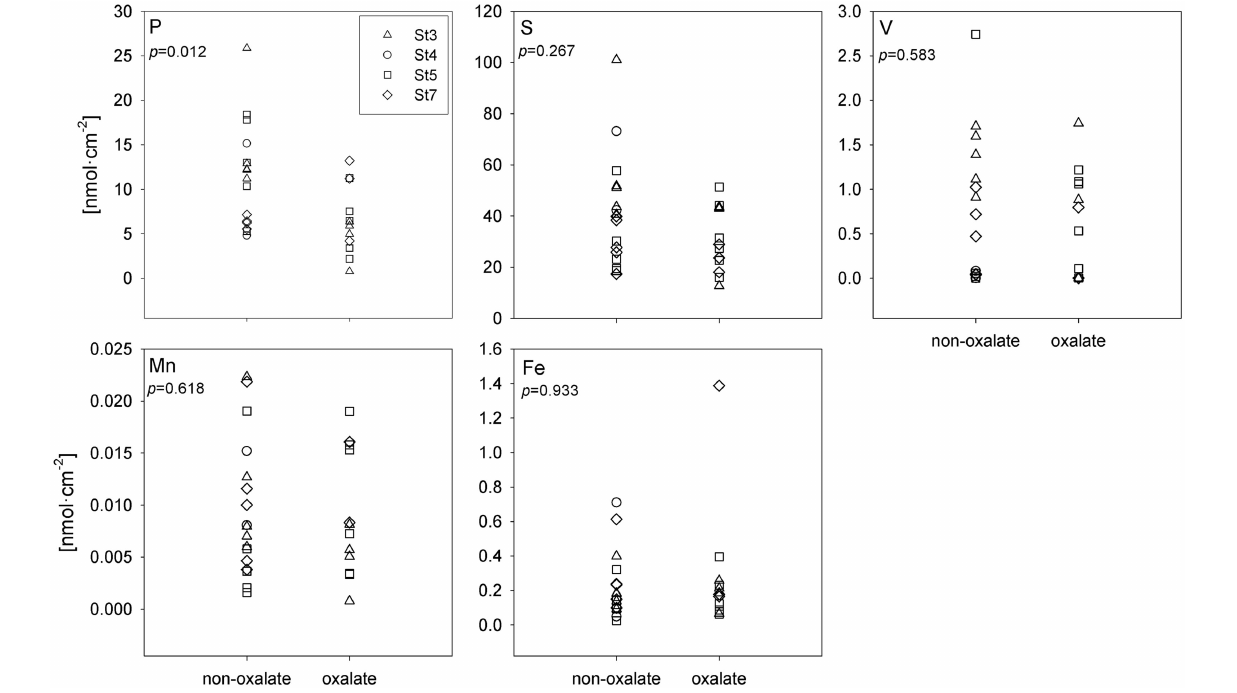
symbol: St 3 – triangle, St 4 – circle, St 5 – square, and St 7 – diamond.The statistical significance of the effect of oxalate rinsing on the metal quotas (as determined with a two-way ANOVA; see text), is shown in each panel.